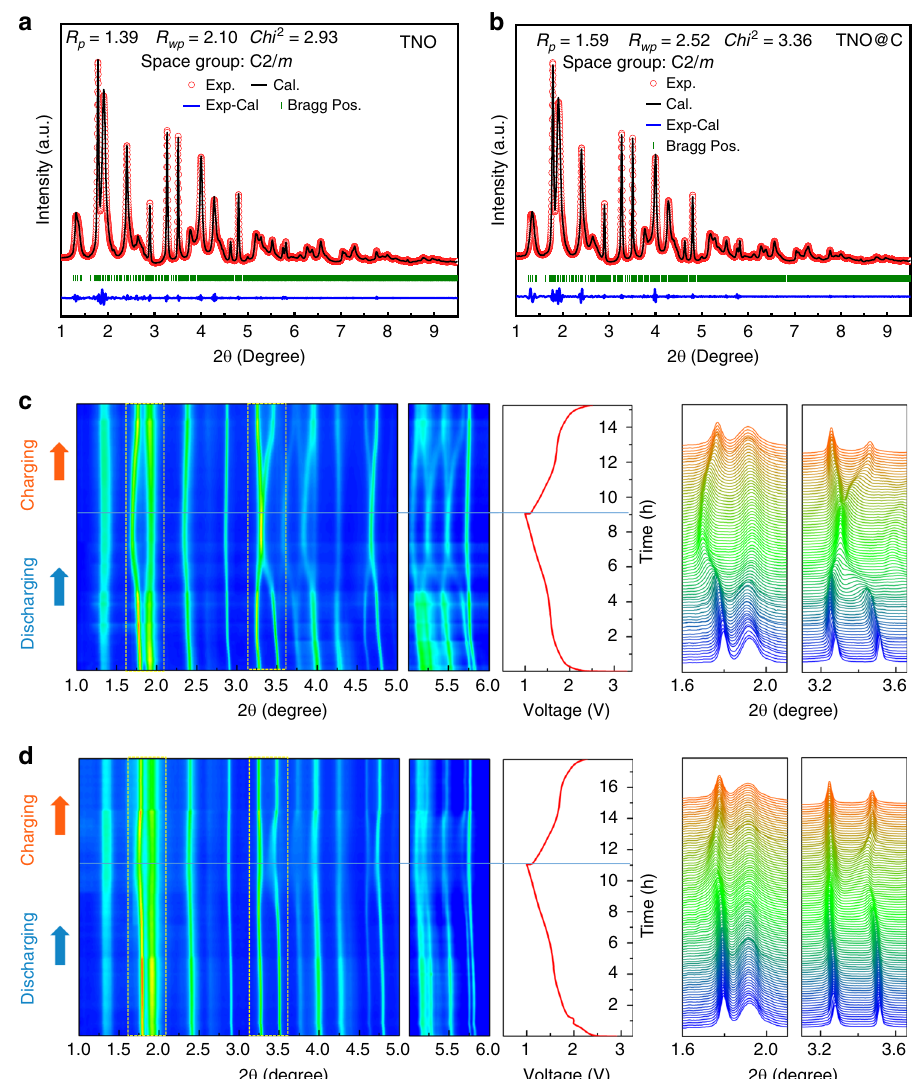
Fig. 6 Synchrotron HRXRD characterization of TNO and TNO − x @C 3 . a Ex situ synchrotron HRXRD characterization of TNO. b Ex situ synchrotron HRXRD characterization of TNO − x @C 3 . c In situ synchrotron HEXRD characterization voltage pro fi le and corresponding contour plot of the XRD pattern evolution of TNO during the fi rst charge – discharge process. d In situ synchrotron HEXRD characterization voltage pro fi le and corresponding contour plot of the XRD pattern evolution of TNO − x @C 3 during the fi rst charge – discharge process. (Contour plot of the (011), (400), (317), and (700) peaks